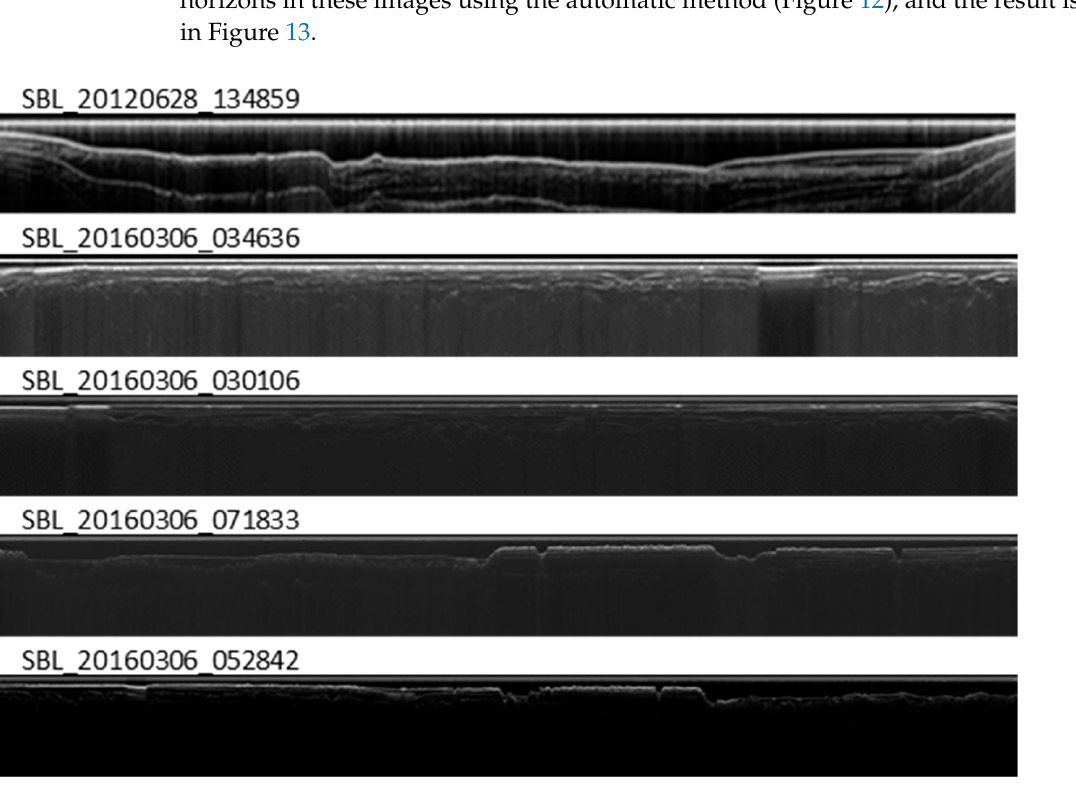
Figure 12. The process of automatic horizon picking. We split the SBP images (Figure 11) into tiles (513 × 513) as the training inputs. For training labels, we first split the images (Figure 13) that are processed by the automatic picking method into tiles (513 × 513). Then we connected discontinuous horizons and re- moved obvious outliers in these tiles manually. The recovered tiles are regarded as train- ing labels that have both the objectivity of machine recognition and the accuracy of man- ual recognition. We obtained 210 training tiles and 90 validation tiles. The process is